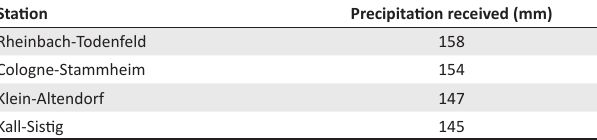
TABLE 1: Weather stations that received the highest precipitation from 14 to 15 July 2021.